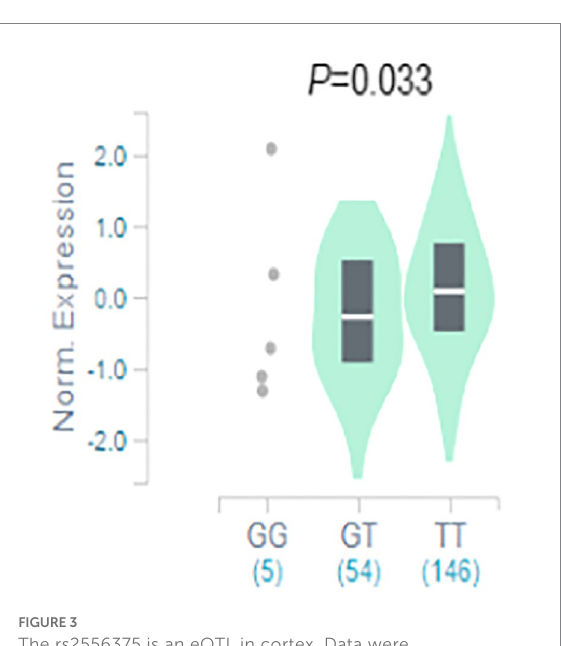
However, the association between the common BCL11A SNPs and epilepsy and the association between the common BCL11A SNPs and therapeutic response of patients with epilepsy in Han Chinese